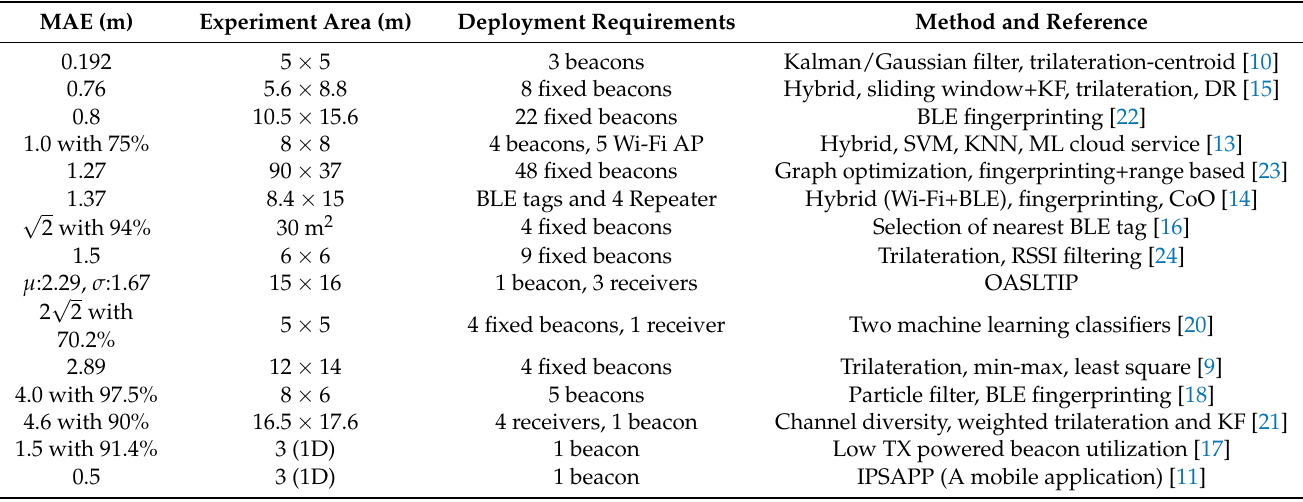
Table 1. BLE indoor positioning-related